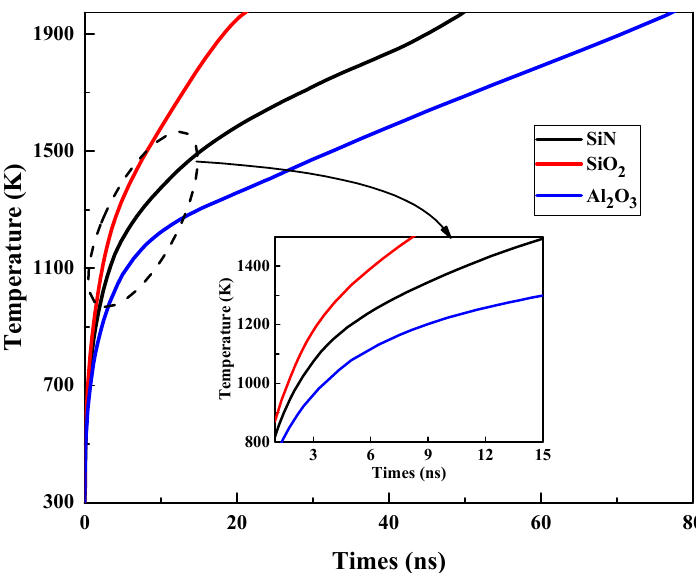
Figure 11. Variation in the maximum temperature ( T max ) inside the GaN HEMT with injection time for different passivation layers.